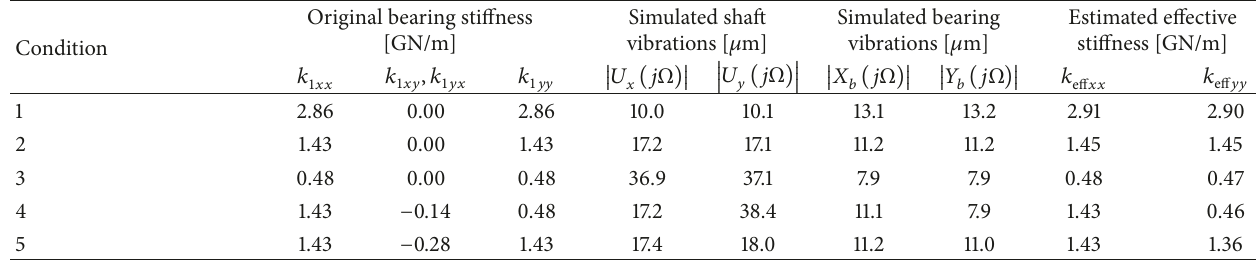
Table 5: Original and estimated bearing effective stiffnesses of the lower journal bearing ( k 4x = k 4y = 2.22 GN/m) of a 700 MW hydrogenerator, using synthesized shaft and bearing vibration signals.